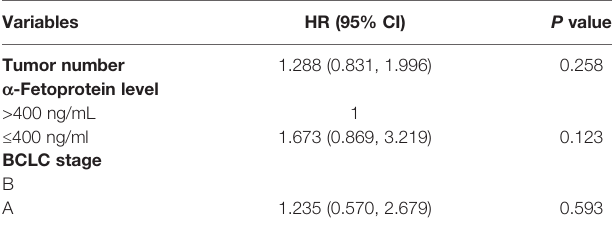
TABLE 3 | Multivariate analysis of prognostic factors for overall